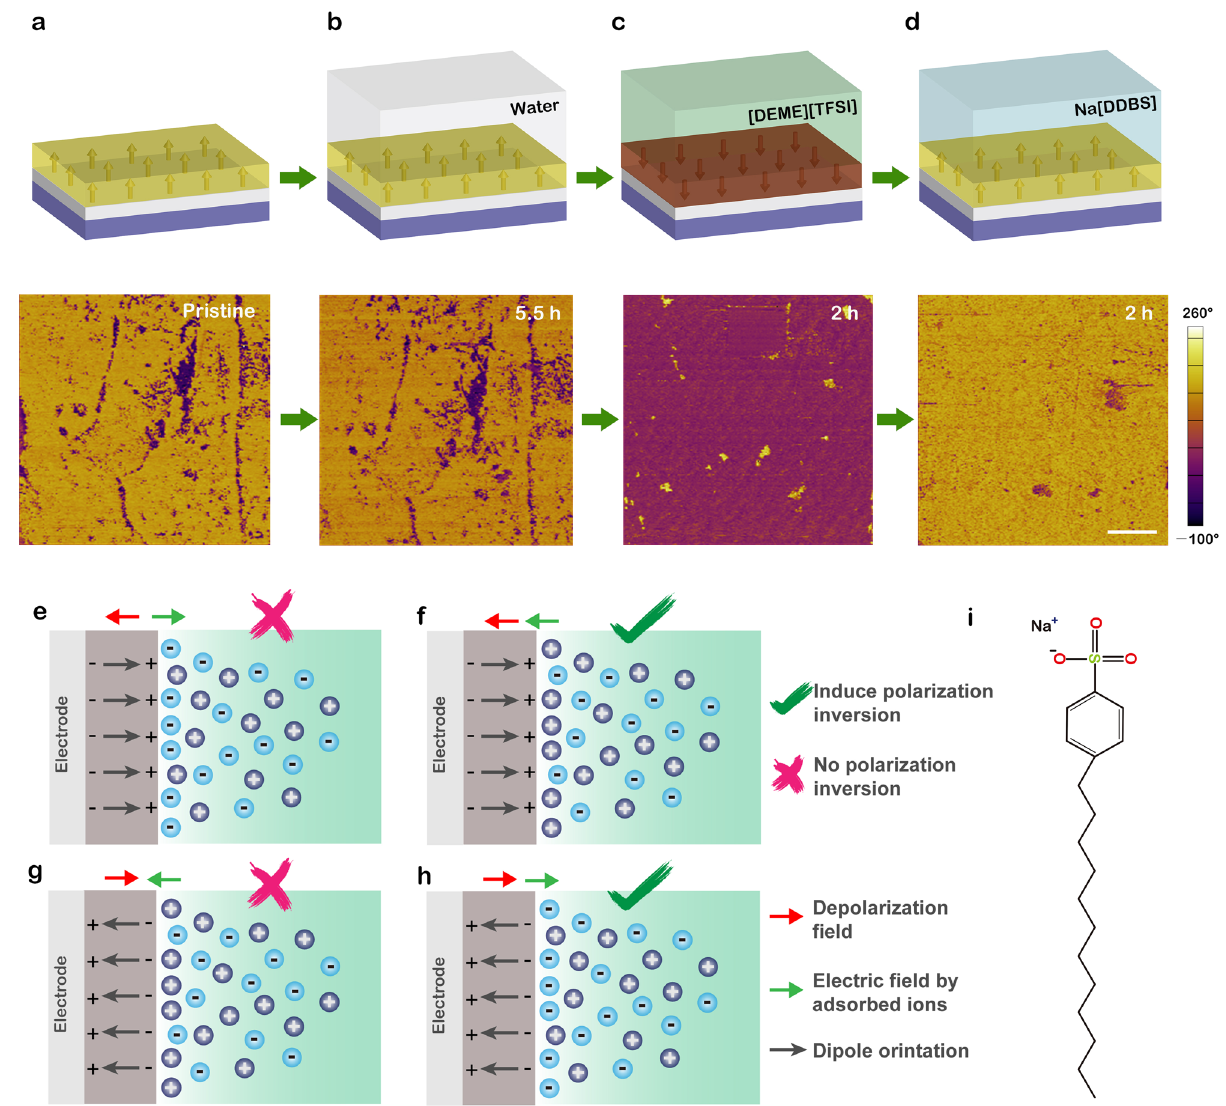
Fig. 3 Ion adsorption-induced reversible polarization switching. a – d Schematic diagrams and corresponding PFM phase changes of the same CIPS nano fl ake after exposing to water ( b ), ionic liquid [DEME][TFSI] ( c ) and Na[DDBS] solution ( d ), respectively. Scale bar in ( d ), 3 μ m. e – h Diagrams of four possible ion adsorption scenarios for upward ( e ), ( f ), and downward ( g ), ( h ) polarization surfaces, respectively. i The molecular structure of Na[DDBS]